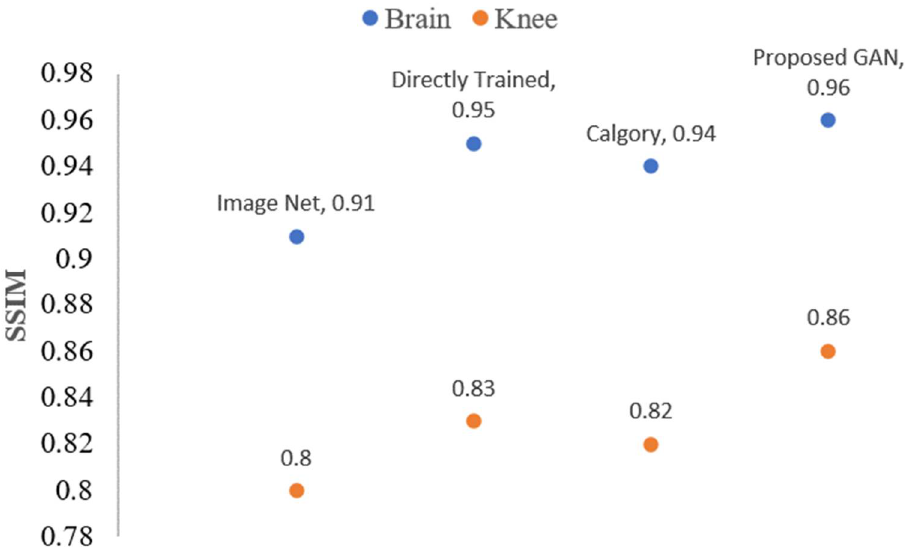
Figure 18. The blue dots represent brain data SSIM values, while orange dots represent knee data SSIM values of the reconstructed images when AF = 4 following TL.